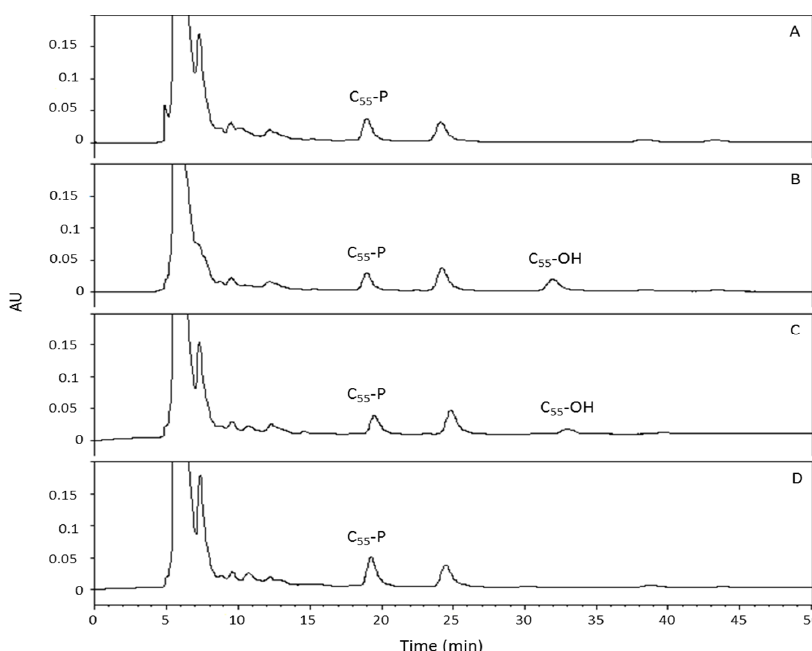
Figure 4. HPLC analysis of membrane extracts (Bligh and Dyer procedure) prepared from E. coli FB8 cells carrying either the empty pASK vector ( A ) or pASK plasmids expressing the wild-type PcaM1 ( B ), its isolated cytotoxic domain ( C ) or the D222A mutant ( D ), respectively. Cells were grown